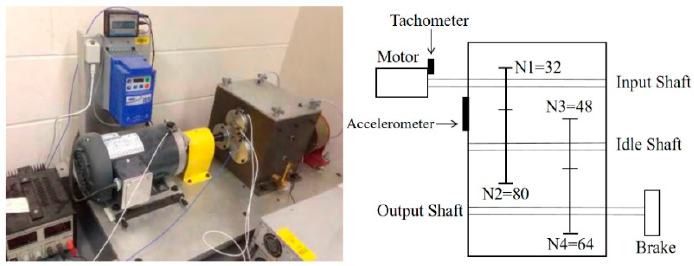
Figure 11. Gearbox experimental platform.